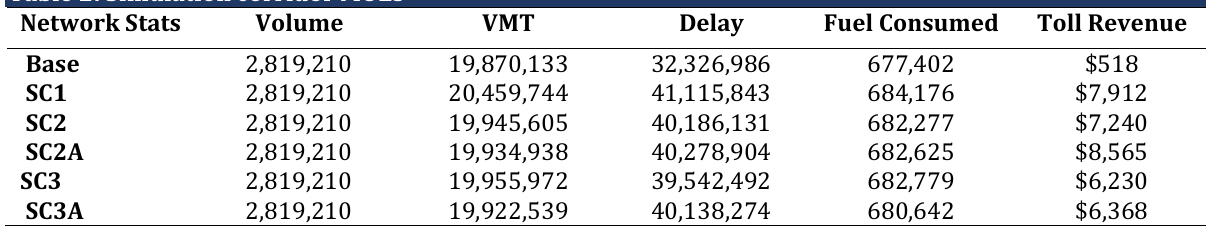
Table 2: Simulation corridor MOEs